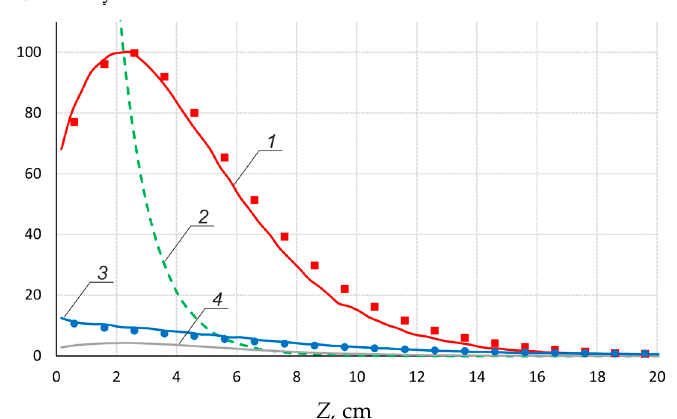
Figure 5. Depth distribution of boron dose ( ▪ ) and γ -ray dose ( ● ) in a water phantom 33 × 33 × 31.5 cm 3 close to the target at 2.05 MeV 1 mA proton beam. The calculated components of the absorbed dose: 1 —boron dose, 2 —fast neutron dose, 3 — γ -ray dose, 4 —nitrogen dose.